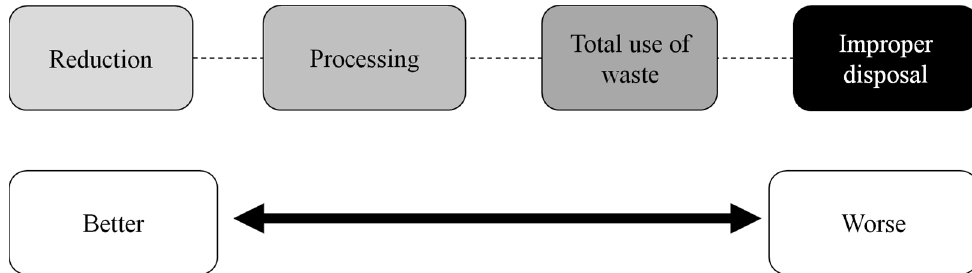
Figure 1. An ideal process should avoid generation of waste. Adapted from Pelizer, Pontieri and Moraes [68].